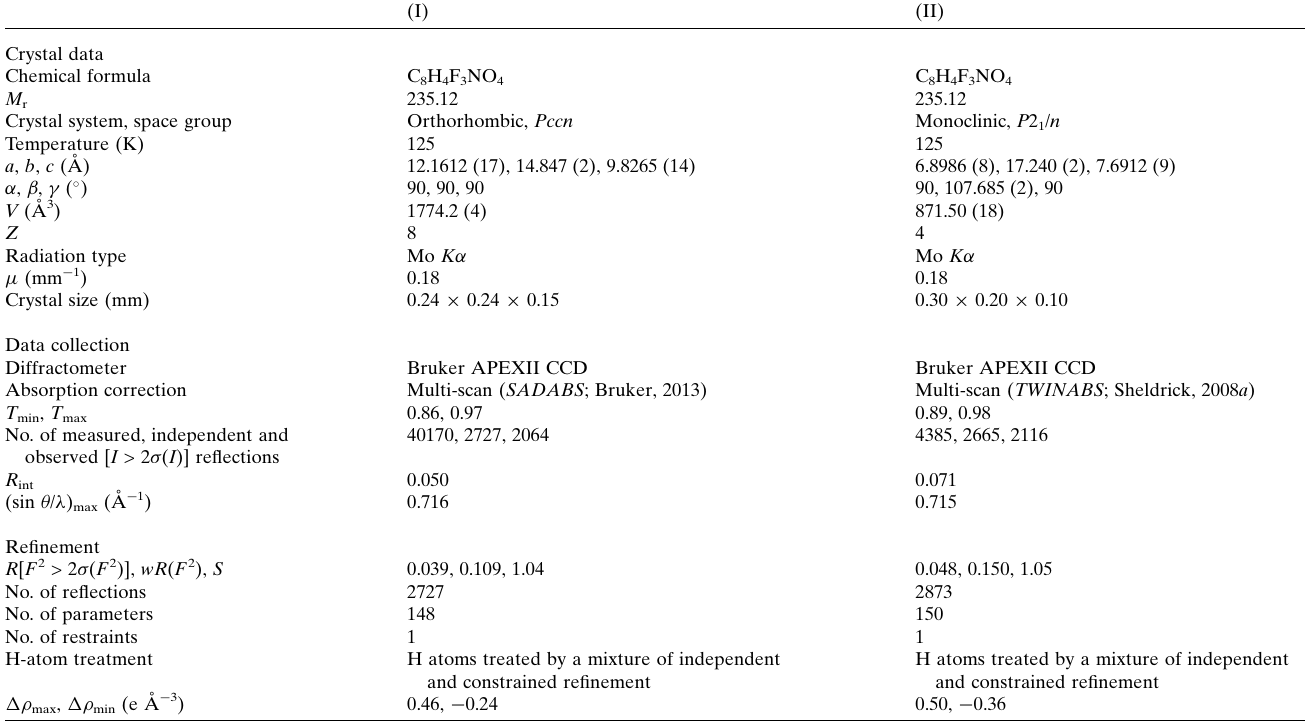
Table 3 Experimental